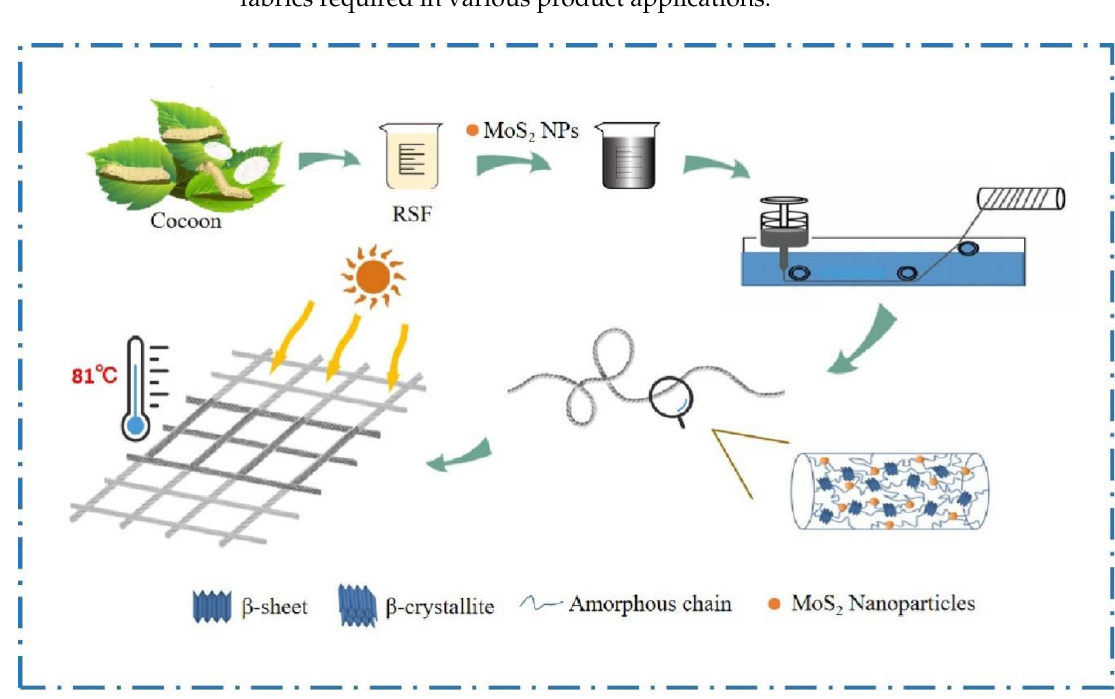
Figure 11. Schematic illustration of RSF/MoS 2 NPs hybrid fibers with high toughness and photothermal properties.